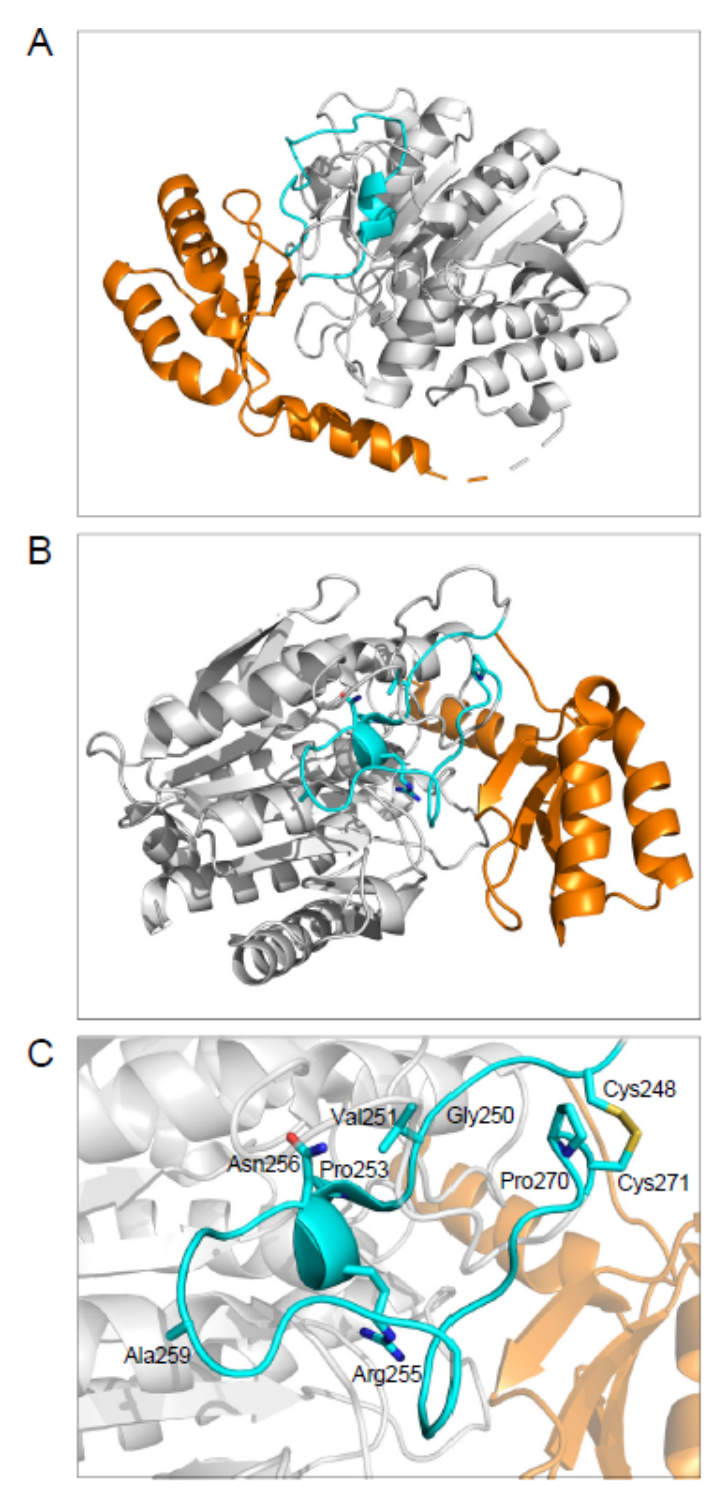
Figure 3. Structure of human pancreatic proCPA1. ( A ) Side view (Protein Data Bank code 5OM9). The propeptide (residues 17–110) is highlighted in orange, the loop formed by residues 248-271 is in cyan, and the rest of the structure is shown as grey cartoon. ( B ) Top view with emphasis on the loop stabilized by the disulfide bridge between residues Cys248 and Cys271. ( C ) Magnified view of the 248-271 loop. The side chains shown in stick representation are Cys248, Val251, Arg255, Asn256, Ala259, Pro270, and Cys271. The position of Gly250 is also indicated.